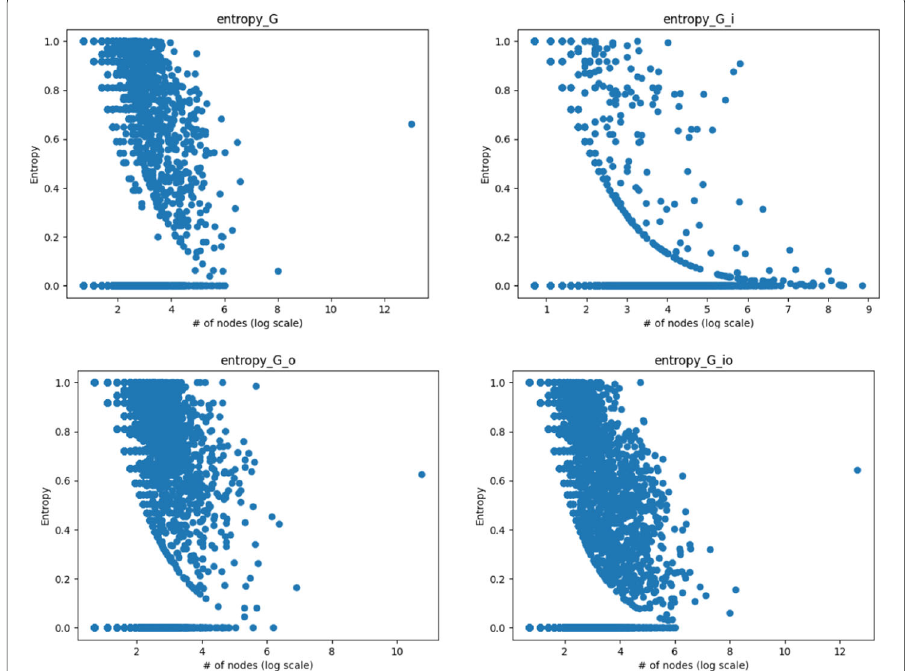
Fig. 7 Entropy of connected components in G , G i , G o , and G io vs. size of connected component measured using number of nodes. The text provides an explanation of the base b used in the logarithm of the entropy formula. The plots are on a semi-log scale, where the x-axis is on the log scale and the y-scale is on the ordinary scale in the [0,1]